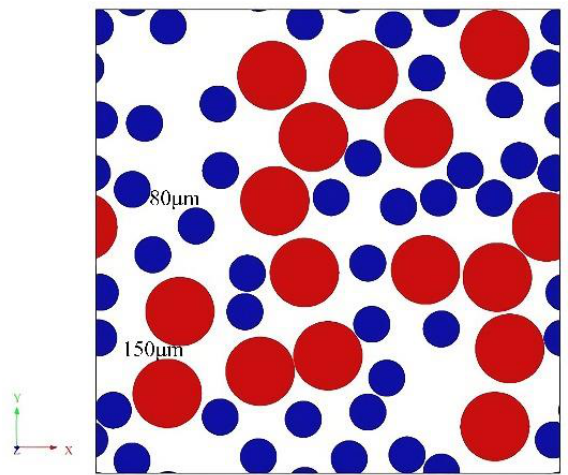
Figure 7. Random round particle distribution geometric model with volume fraction of 40%.